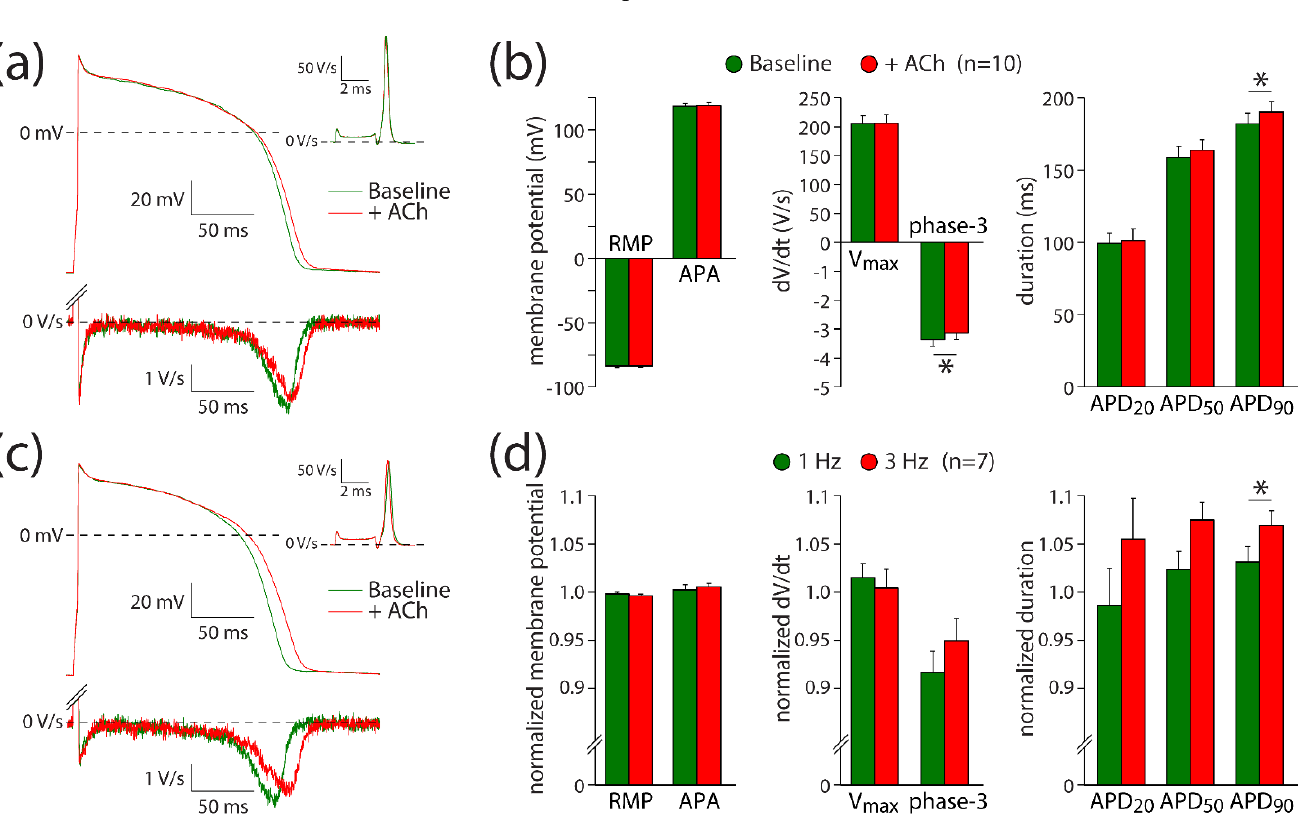
(Figure 4a, bottom panel; Figure 4b; paired t -test; t(9) = − 2.407, p = 0.039). The maximal phase-3 repolarization rate decreased from 3.4 ± 0.2 V/s under baseline conditions to 3.1 ± 0.2 V/s ( n = 10) in the presence of ACh.